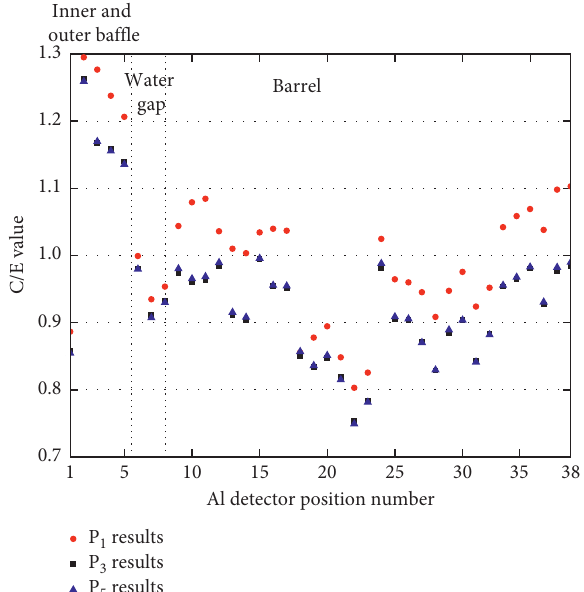
Figure 16: Comparison of Legendre expansion order of the 27 Al(n, α ) 24 Na detector.